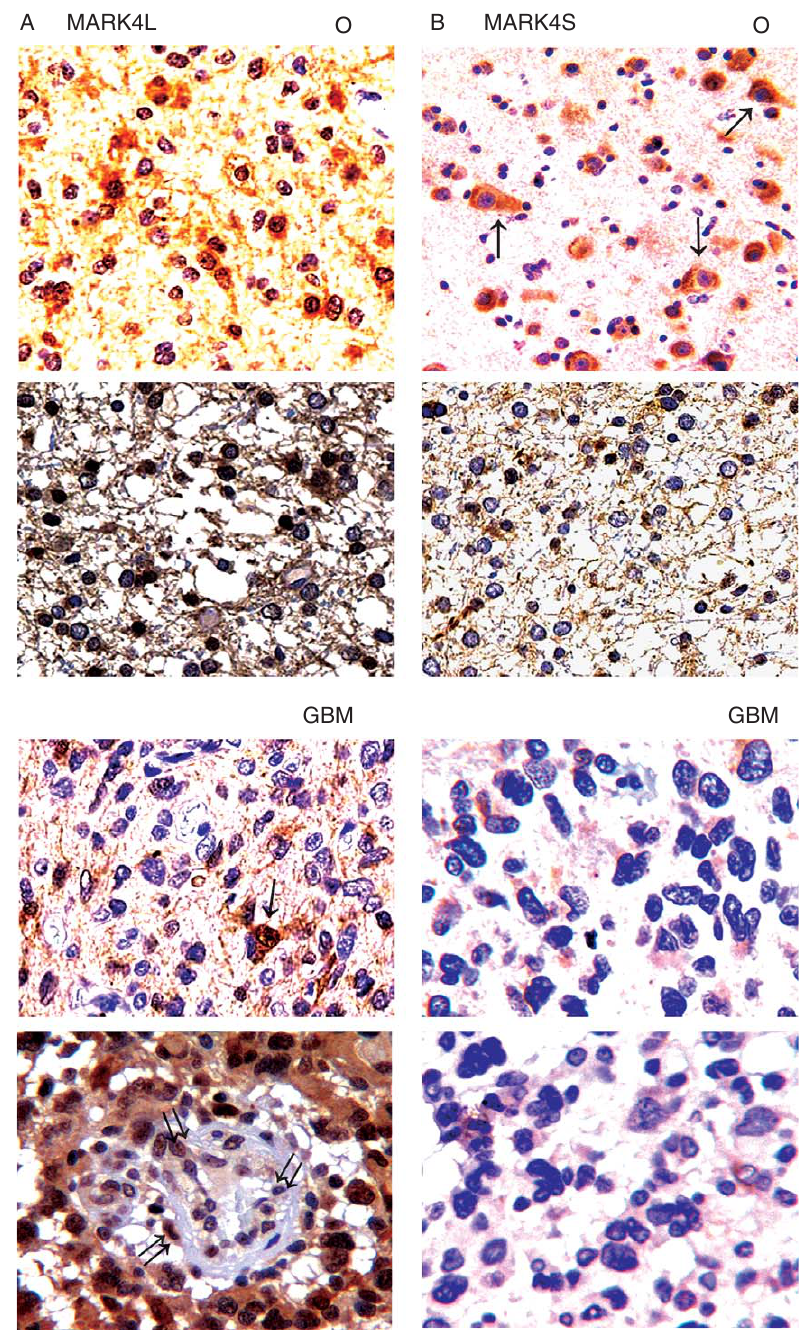
Fig. 3. Representative images of MARK4 immunohistochemistry experiments in glioma tissues. (A) MARK4L and (B) MARK4S labelling of O (samples 193 and 196) and GBM (samples 207 and 113). Arrows indicate neurons entrapped in the tumor mass labelled by both MARK4 antibodies. Double arrows point to endothelial cells expressing MARK4L. IHC was performed using the DAB method with haematoxylin